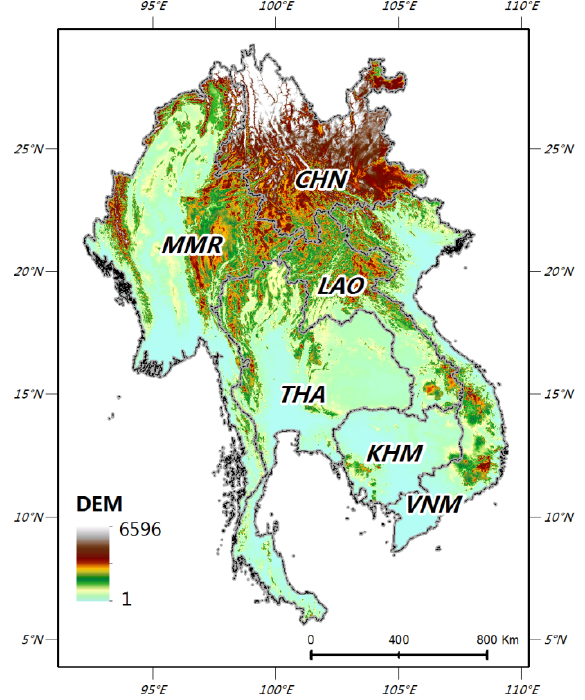
Figure 1. Distribution of the Lancang-Mekong sub-region (Notes: CHN: China, LAO: Laos, MMR: Myanmar, THA: Thailand, VNM: Vietnam, KHM: Kingdom of Cambodia).